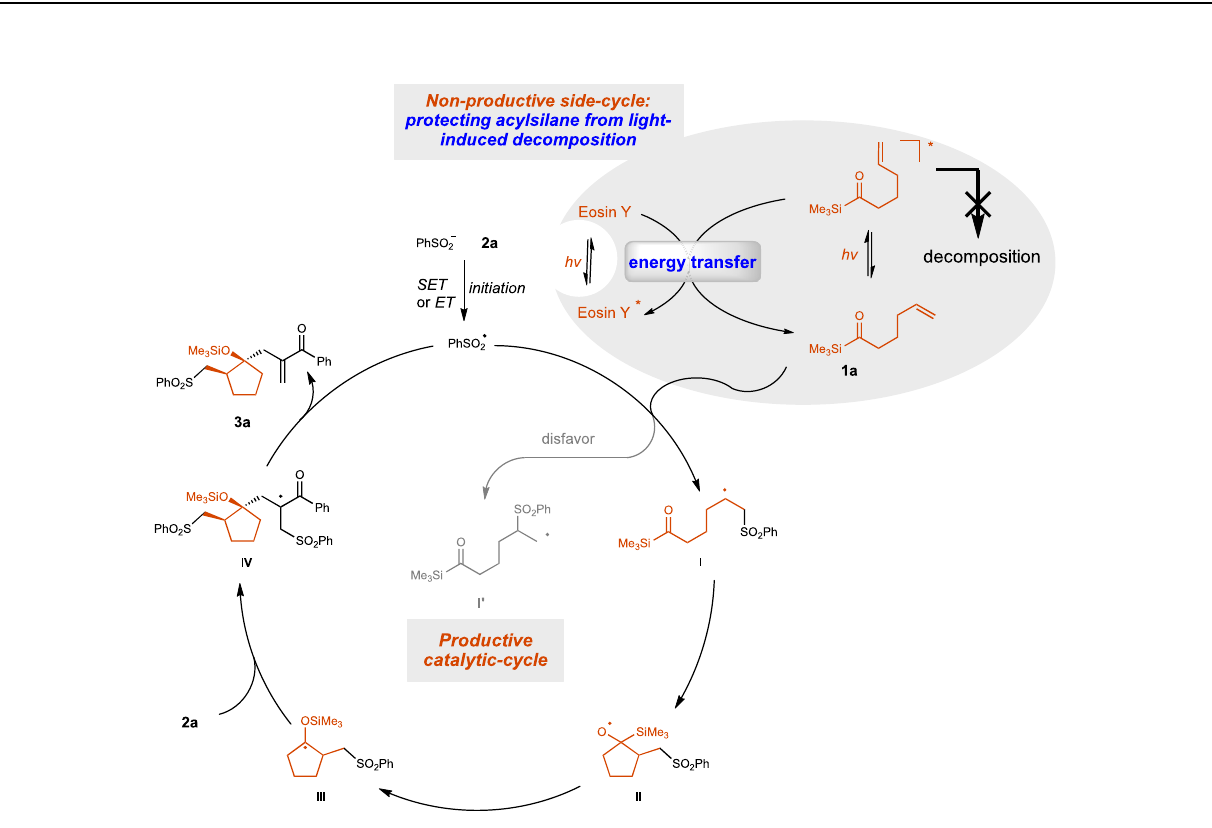
Fig.9|Proposedmechanism. TheunproductiveenergytransferfromexcitedacylsilanetoEosinYinhibitedthelight-induceddecompositionofacylsilanes,enablingthe desired cascade cyclization reaction to generate cyclopentanol